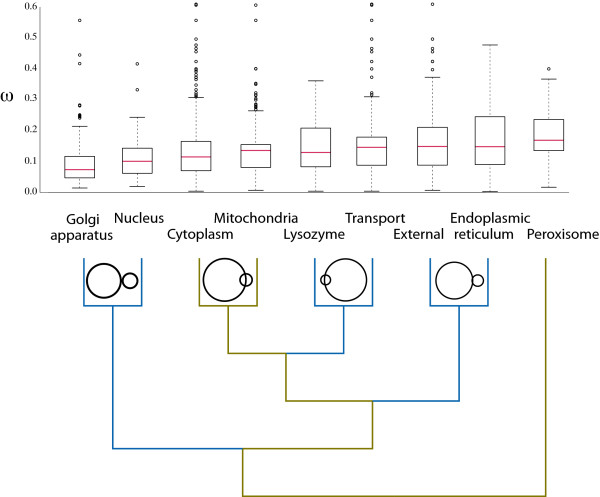
Hierarchical clustering of cellular compartments based on selective constraint. Genes are split into nine groups based on their subcellular location (see main text). The median box plots show the distribution of ω values for each compartment - all data, including outliers, are used in the analysis. Using the mean ω values, we created a phenogram using the UPGMA algorithm (branch lengths are arbitrary). Each branch is colored gold if a Mann-Whitney U-test found that the distributions were significantly different at P ≤ 0.01, and blue otherwise. For example, the cytoplasm and mitochondria distributions are significantly different (P = 0.01), but the lysozyme and transport groups show no significant difference (P = 0.087). However, when the group formed by the cytoplasm and mitochondria is compared to that formed by the lysozyme and transporters, there is a statistically significant difference (P < 0.001). The 4 Venn diagrams show the proportional degree of overlap in genes among groups (sizes are not comparable across nodes in the tree). In none of these cases is any one set of reactions a superset of the other set of reactions.